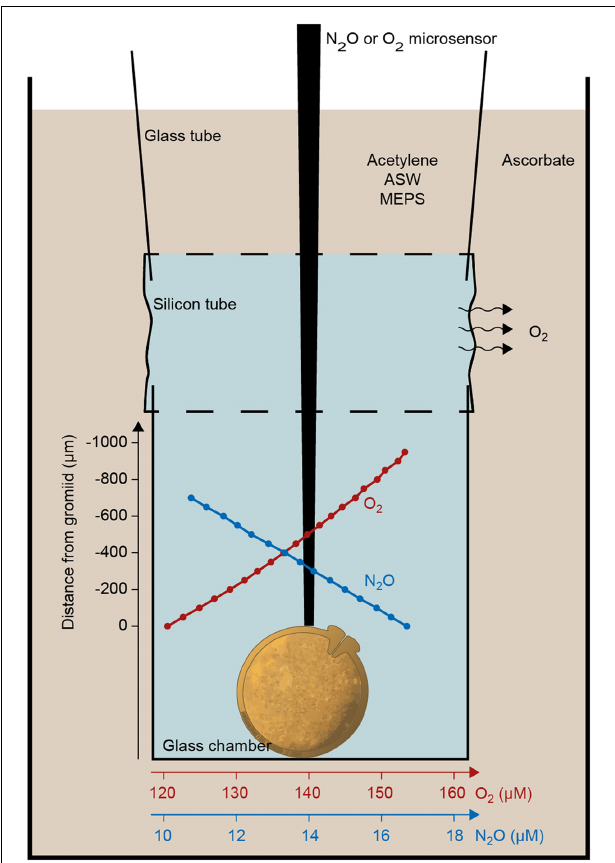
FIGURE 2 | Experimental setup for microsensor measurements of oxygen and nitrous oxide profiles above single gromiid cells. An example of oxygen and a nitrous oxide profile is shown in red and blue. Oxygen profiles were measured during oxic conditions where ascorbate was replaced by artificial